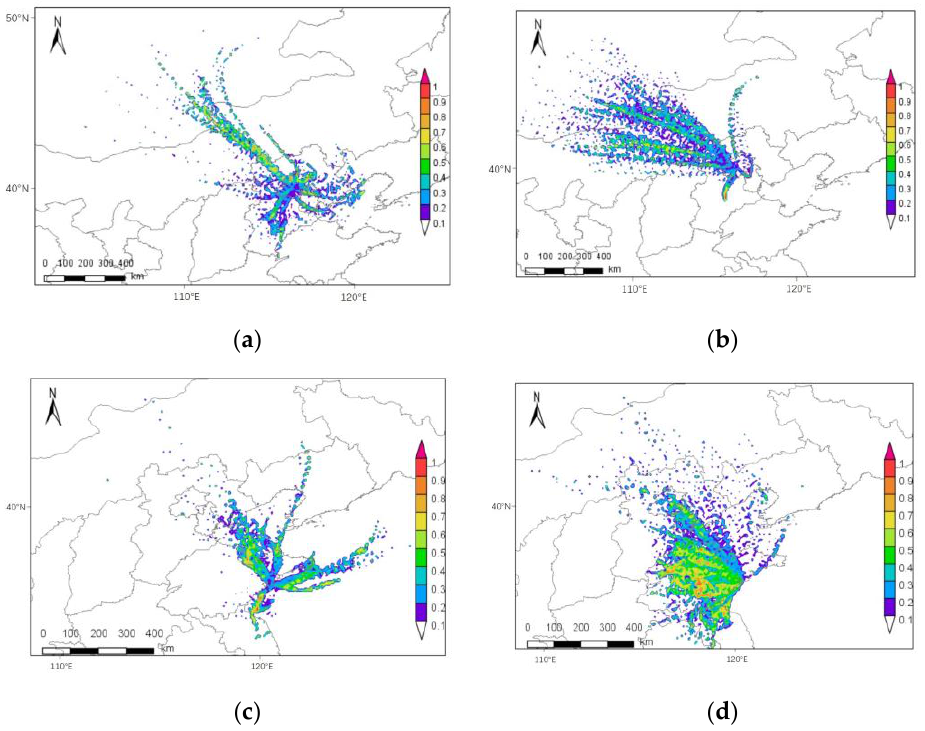
Figure 3. Distribution of potential source of PM 2.5 in autumn (September, October, November) and winter (December) in Beijing ( a , b ) and Qingdao ( c , d ), respectively. As the PSCF method can only analyze the proportion of pollution trajectories in a certain grid, it cannot indicate the contribution of the grid to the pollution of sampling sites. The concentration-weighted trajectory (CWT) analysis was calculated based on the backward trajectory data during the sampling period. The results of Beijing and Qingdao are presented in Figure 4. The darker the color was, the higher the level of the grid con- centration was.